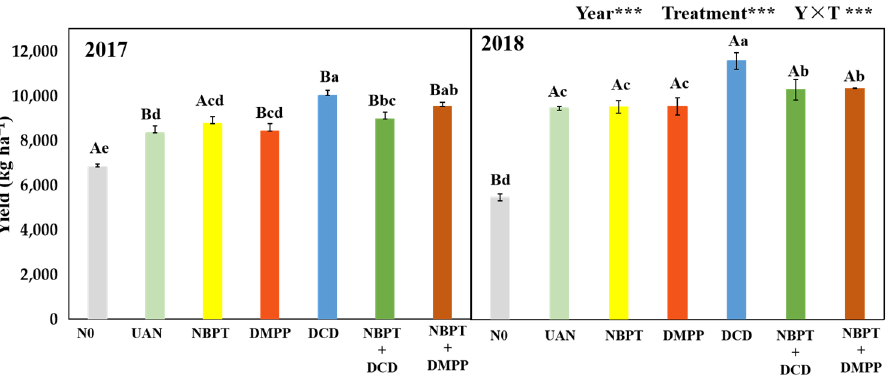
Figure 2. Maize yield of the different sources of N fertilizer in 2017 and 2018. Note: *** indicate significance at p < 0.001. Different capital letters above the bars indicate significant differences among years at p < 0.05. Different lowercase letters above the bars indicate significant differences among treatments at p < 0.05. Letters on the top of the histogram marked with at least the same letter do not differ significantly ( p = 0.05).